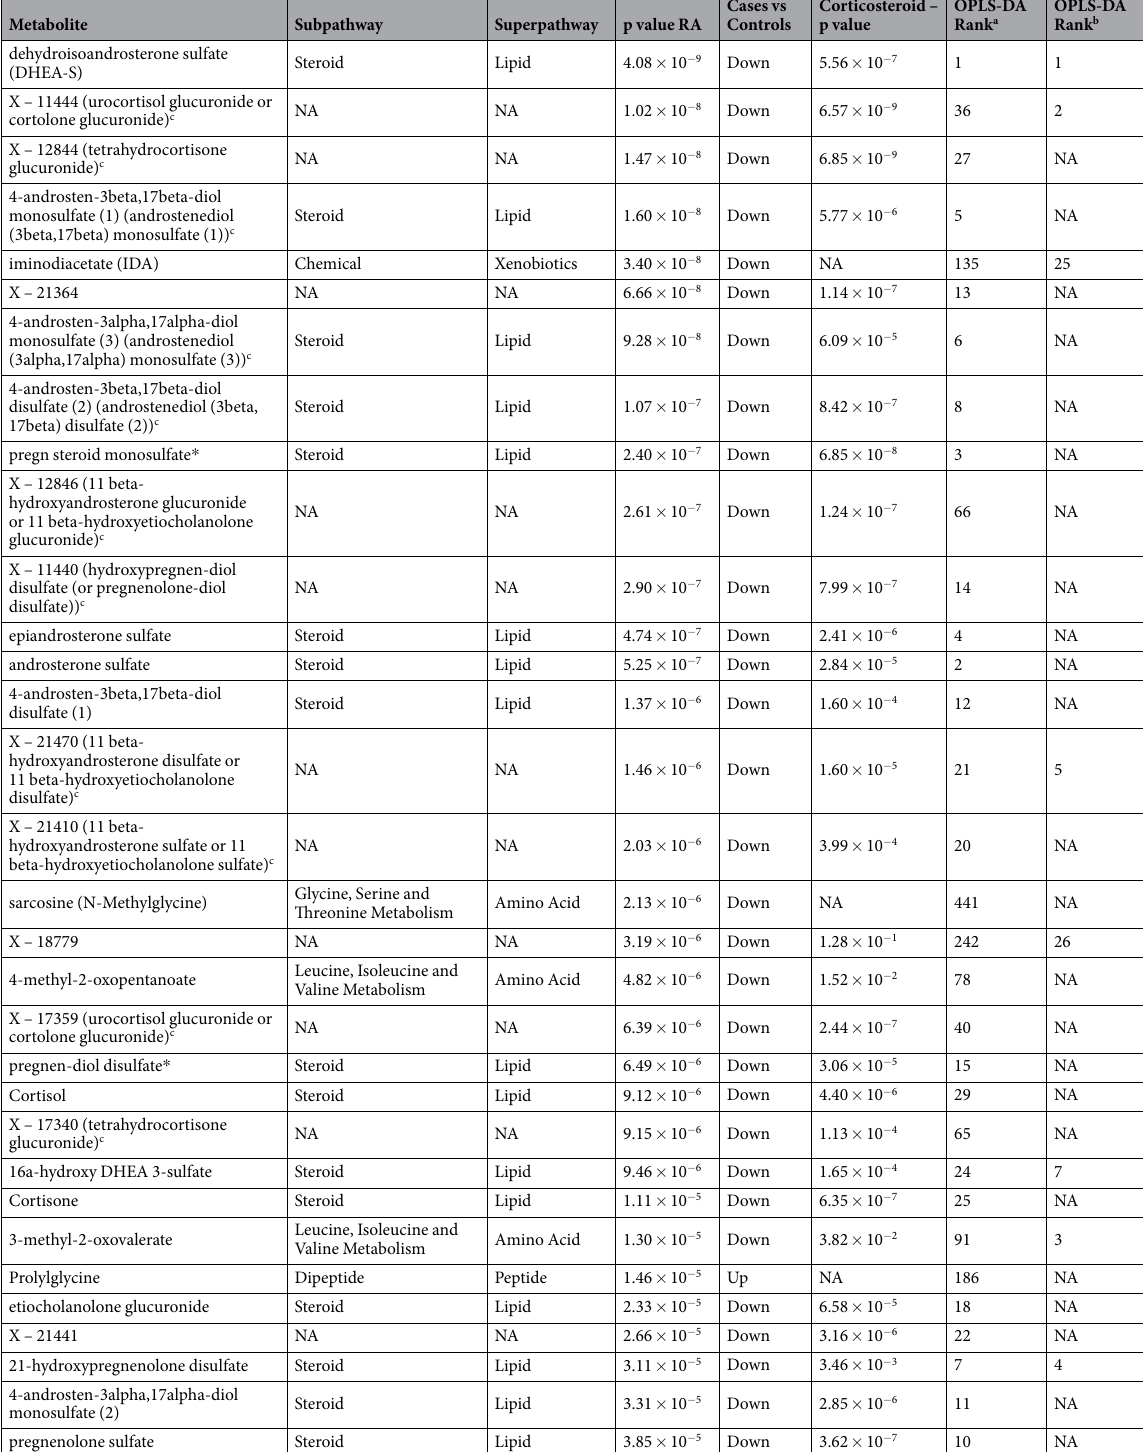
Table 2. 32 Metabolites with Bonferroni significant association to RA compared to controls. Metabolites are sorted on their significance of association to RA. a,b Results from OPLS-DA analysis when considering all variables (all metabolites and all covariates), and after feature selection respectively. c Tentative identification/renaming by Metabolon, and in some cases indicates same identification for two unknown metabolites. * Indicates a compound that has not been officially confirmed by Metabolon based on a standard but it is confident of its